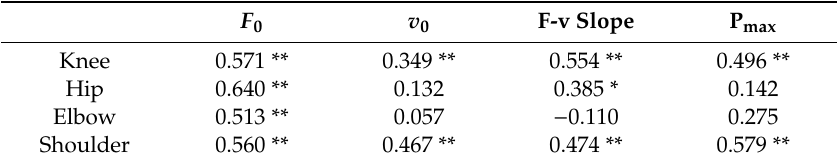
Table 2. Association of the force-velocity relationship parameters between flexor and extensor muscles acting on the same